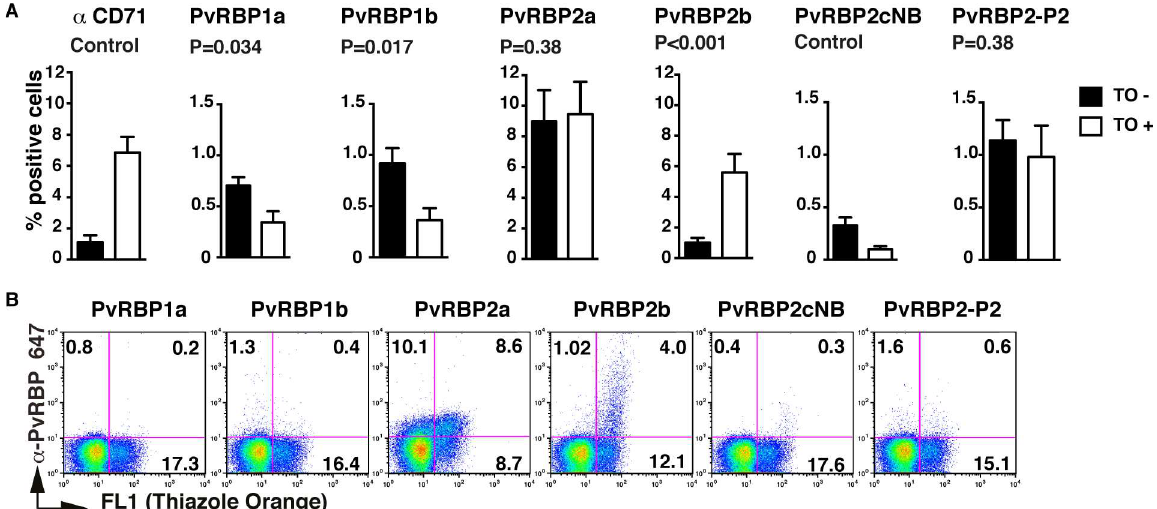
Fig 1. Erythrocyte-bindingpreferences of 6 PvRBPs. A: Bar chartsshowing the percentageof bindingof CD71-PECy5 (control), PvRBP1a, PvRBP1b, PvRBP2a, PvRBP2b, PvRBP2cNB, PvRBP2-P2 to matureerythrocytes(not stainedwith thiazole orange, TO-) vs reticulocytes (stainedwith thiazole orange, TO+) populations. Errorbars represent SEM of 7 or 9 independent repeats.B: Dot plots show the bindingof six PvRBP proteinsto an enrichedreticulocytepopulation.Bindingwas detectedusing an anti-PvRBPrabbit IgG antibodyfollowed by a secondary anti-rabbitAlexa 647